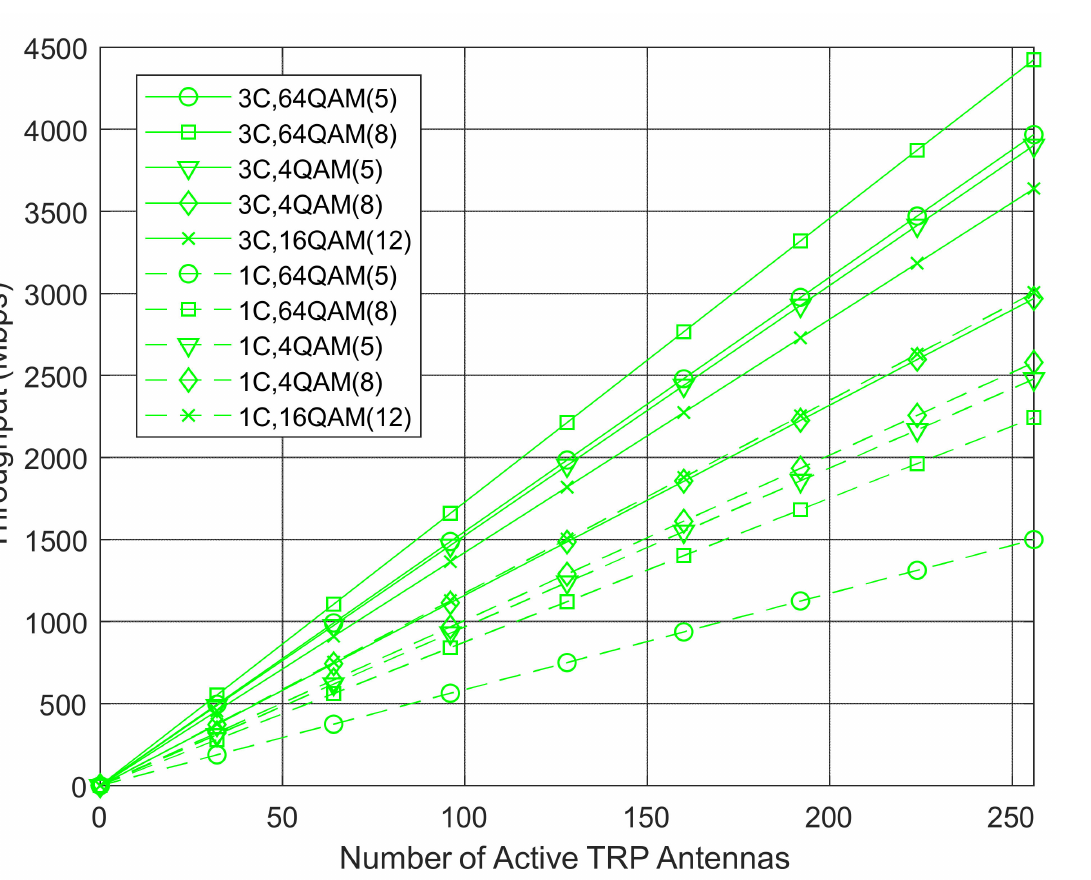
Figure 12. Throughput vs. number of active TRP antennas, for InD scenario, N rx = 5, for two C-RAN cluster sizes, modulations and numbers of antennas per user, namely with N tx /N u = 5, 64QAM(5) and 4QAM(5); with N tx /N u = 8, 64QAM(8) and 4QAM(8); and with N tx /N u = 12,